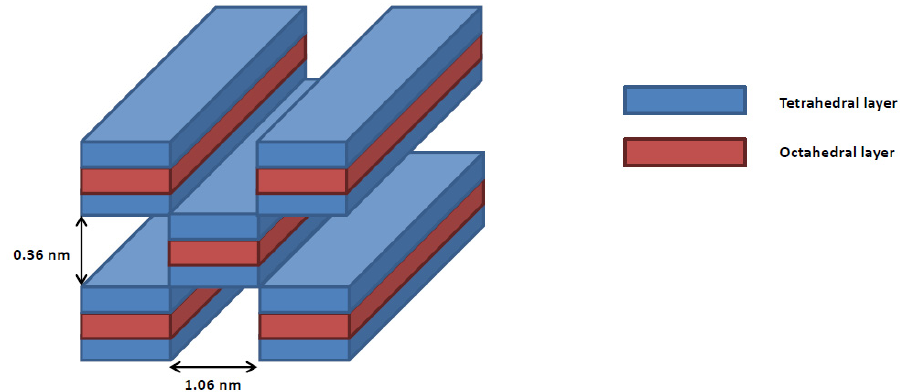
Figure 6. Sepiolite Type 2:1 two tetrahydric silica layers, and another octahedric. On the sepiolite structure, three modification/adsortion zones are distinguished: